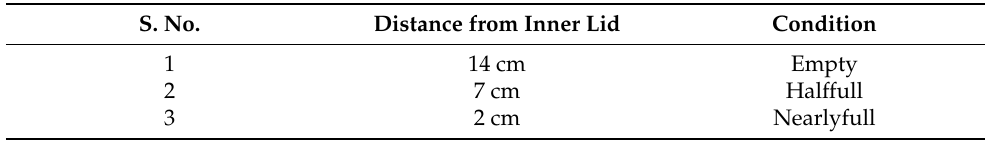
Table 7. Experimental analysis of waste in smart bin.